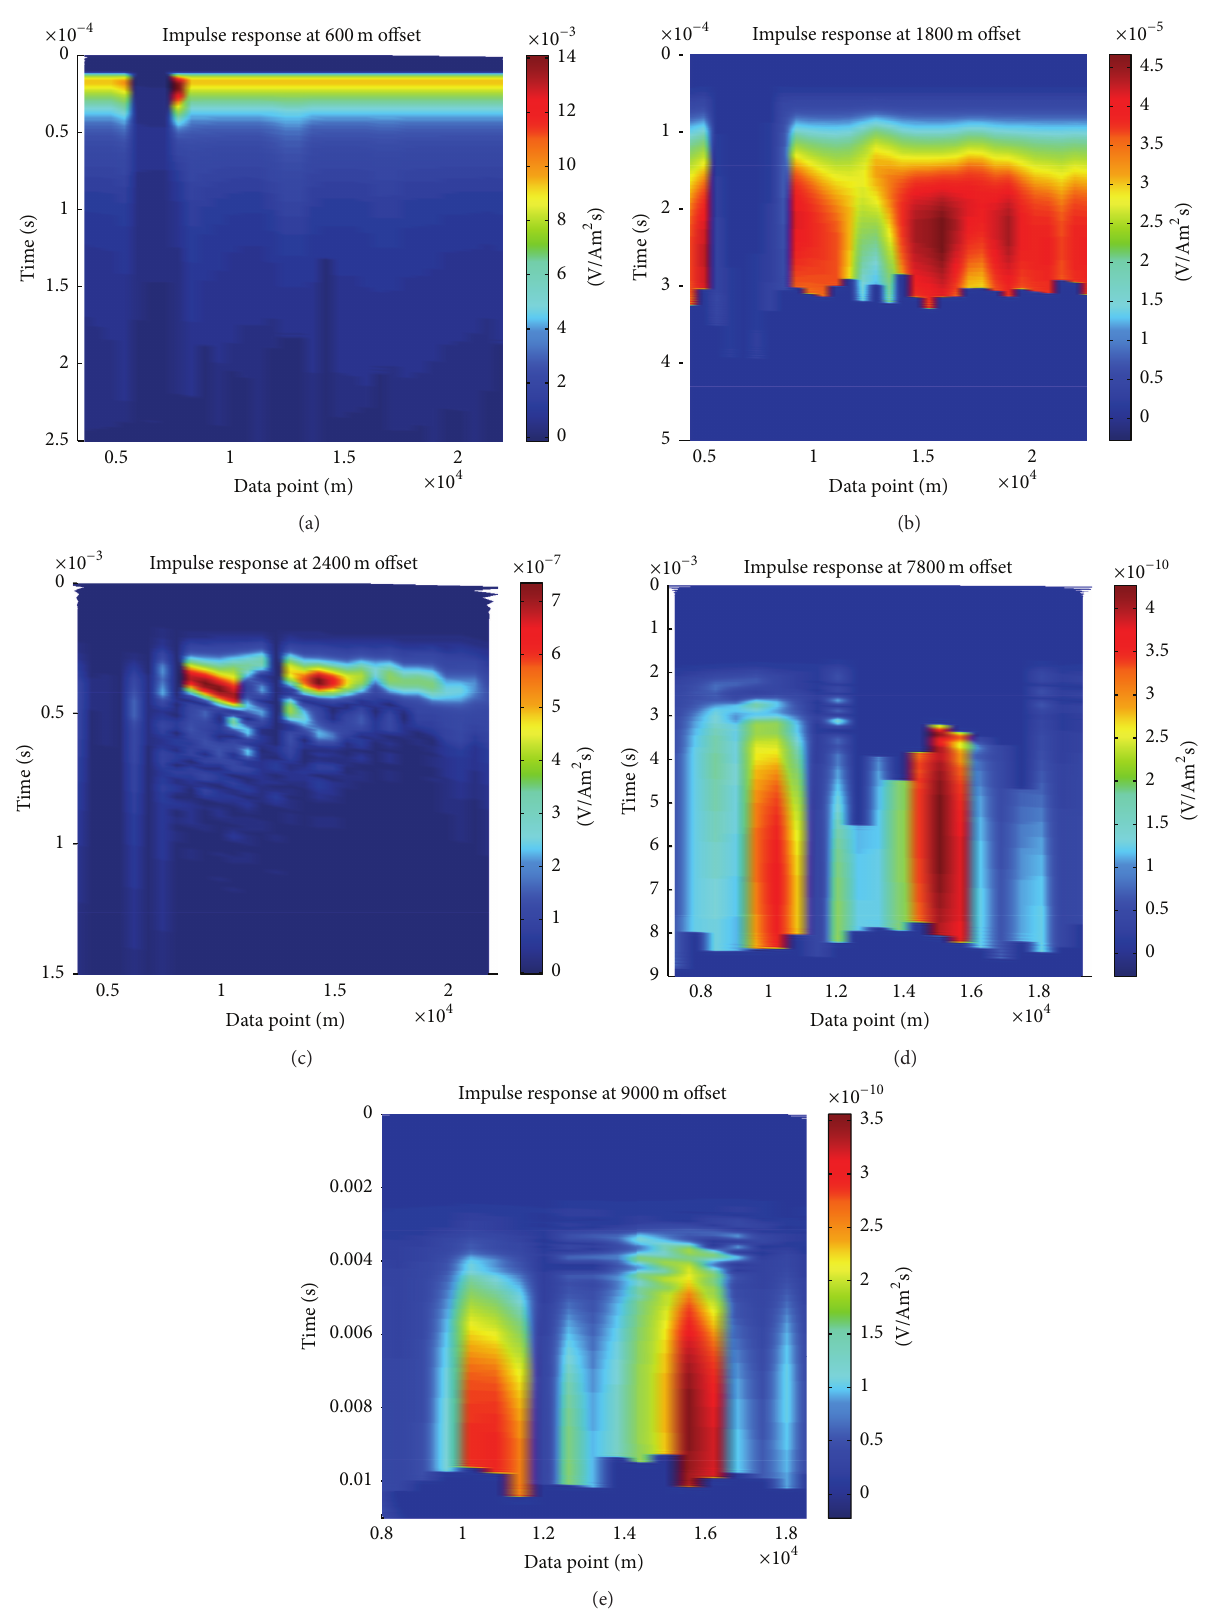
Figure 15: 2D MTEM response displayed as common offset sections of the earth impulse response at offsets (a) 600, (b) 1800, (c) 2400, (d) 7800, and (e) 9000 m. The observed changes in amplitude reflect a corresponding change in subsurface